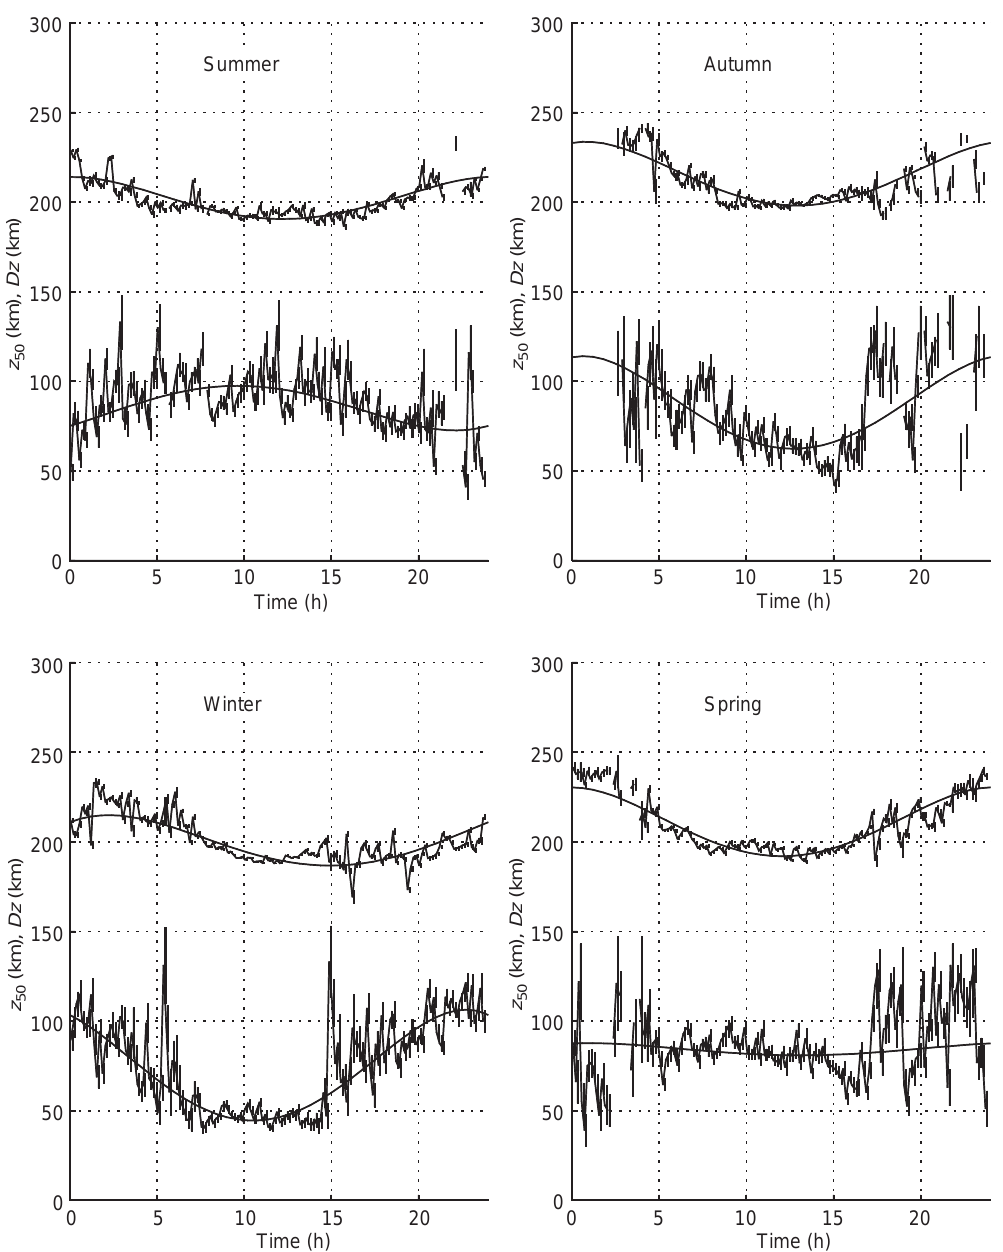
Fig. 3. The averaged values of parameters z 50 ( upper lines ) and dz ( lower lines ) for four seasons for low solar activity. The data were averaged in 10-min bins and are shown with their errors. The smooth lines represent the